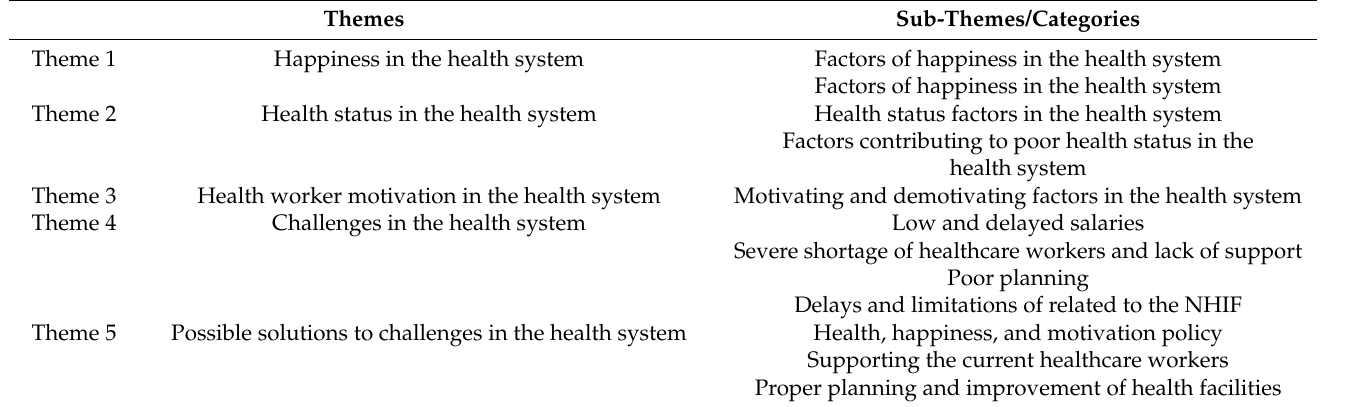
Table 2. Themes and